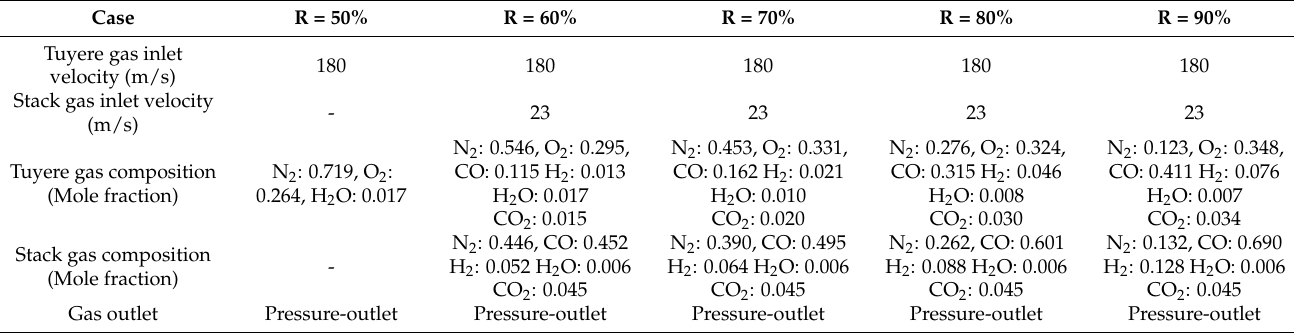
Table 6. Boundary conditions of different cases